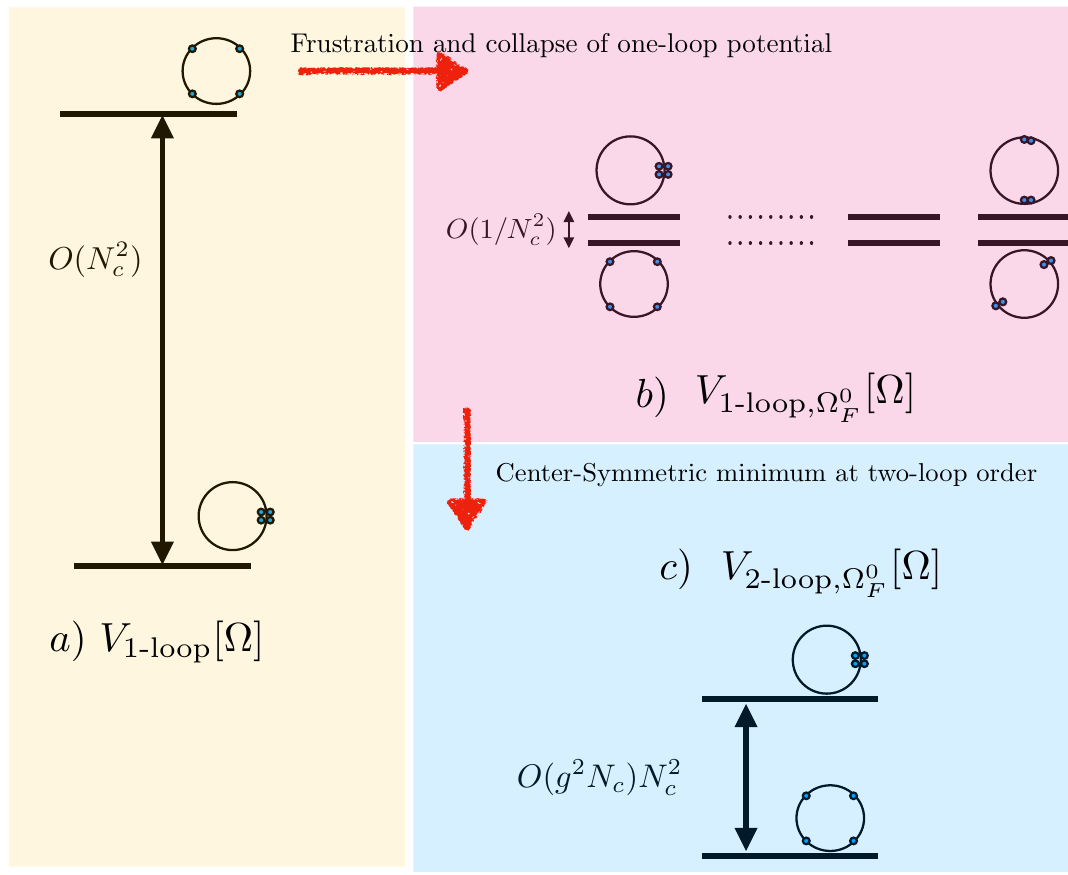
Figure 3 . The figure describes the image of Hilbert space distillation in path integral and gauge holonomy potential description. a) This is the standard implication of Gross-Pisarski-Yaffe analysis. Center-broken configuration is the minimum and governs ground state (thermal equilibrium state properties.) In particular, the center-symmetric configuration is extremely disfavored. The potential gap between min and max is order N 2 . b) The image of distillation of H is the frustration of c GPY potential at one-loop. Now, there are exponentially increasing number of min and max. In particular, the center-symmetric and center-broken configurations are almost on the same footing as the gap between min and max is order 1 /N 2 . c) At two-loop, there is a center-stabilizing double- c trace term in the potential which is resistant to frustration. That term decides the new ground state of the theory, which is now center-symmetric. This holds to all orders in perturbation theory and